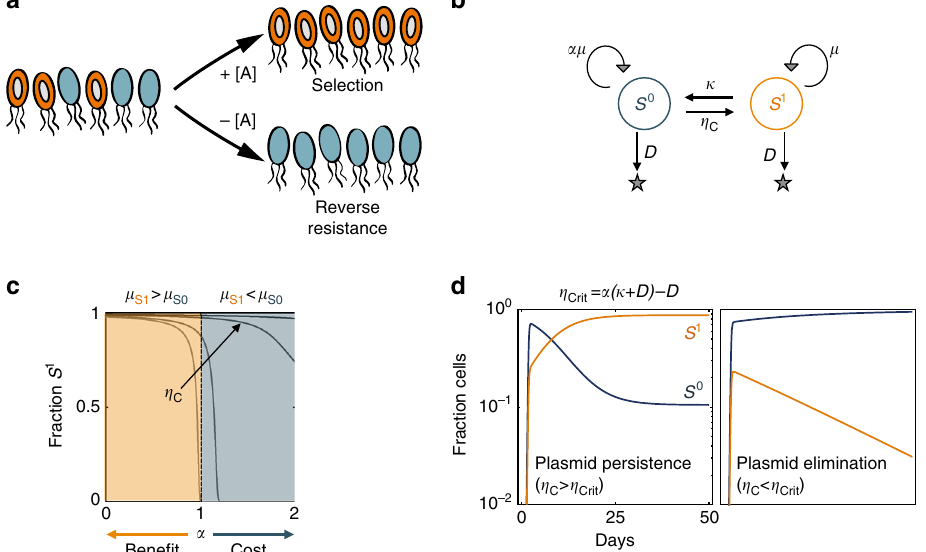
Fig. 1 Conditions for plasmid persistence and elimination. a The concept of resistance reversal. A population initially consists of a mixture of sensitive (blue) and resistant (orange with plasmid) cells. In the presence of antibiotics ( ± indicates presence or absence of [A] antibiotic concentration), resistant cells are selected for. In the absence of antibiotics, as long as the plasmid imposes a fi tness cost, then over a suf fi ciently long time the resistant cells will be presumably outcompeted, effectively reversing resistance. b Modeling plasmid dynamics in a single species ( S ). The plasmid-free population, S 0 , acquires the plasmid through conjugation at a rate constant η , becoming S 1 . S 1 reverts to S 0 through plasmid loss at a rate constant κ . S 0 grows at a rate C proportional to S 1 ( μ 1 = μ , μ 0 = αμ ). The plasmid is costly when α > 1 and bene fi cial when α < 1. Both populations turnover at a constant dilution rate D . c Simulated fraction of S 1 as a function of α and η after 5000 time units (~200 days). Fast conjugation can compensate for plasmid loss even if the plasmid C carries a cost ( α > 1). A greater η is required to maintain the plasmid population as α increases. d Criterion for plasmid persistence. If η C > η ¼ α κ þ D ð Þ (cid:2) D , the plasmid will dominate (Eq. Crit